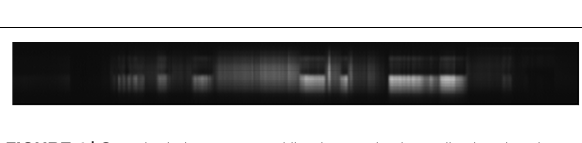
FIGURE 4 | One single hyperspectral line image, horizontally showing the spatial information of one line, vertically showing the spectral reflection between 400 and 1000